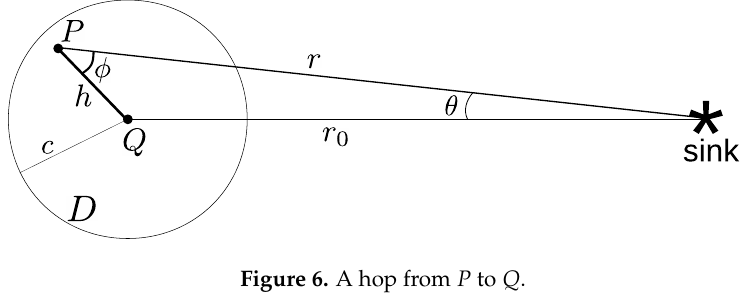
Figure 6. A hop from P to Q